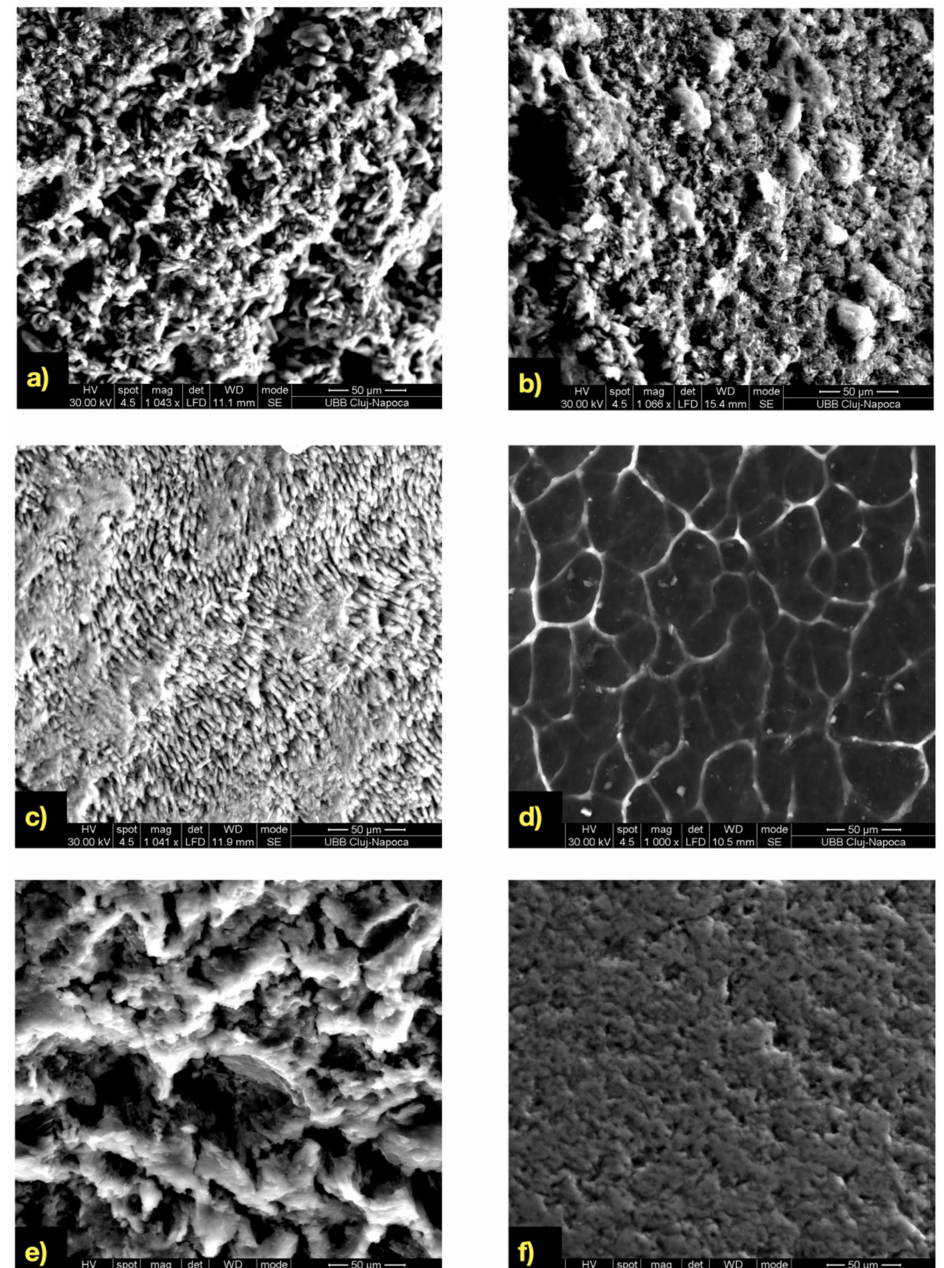
Figure 6. The SEM aspect of the teeth demineralized for 96 h in: ( a ) hydrochloric acid; ( b ) orthophos- phoric acid; ( c ) lactic acid; ( d ) orthophosphoric acid solution; ( e ) formic acid; ( f ) CaCl 2 , NaH 2 PO 4 and acetic acid